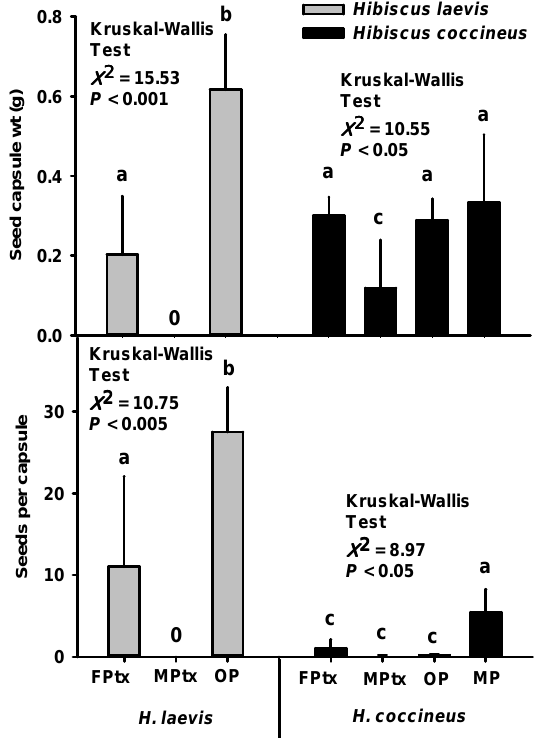
F IGURE 3. Comparative pollination efficiencies of single contact visits by male Ptilothrix bombiformis (MPtx) and females (FPtx) in the 2009 study based on seed capsule weight and seed set (seeds per capsule) of Hibiscus laevis and H. coccineus . For comparison, some flowers were openly pollinated (OP) and manually pollinated (MP) with stigmas saturated with compatible pollen ( H. coccineus only). Bars (+SE) denote mean stigmatic pollen loading per visit. Different letters above the bars indicate means that were different according to multiple comparisons of rank scores using Wilcoxon two-sample exact tests across the two Type II species of Hibiscus : H. laevis and H. coccineus